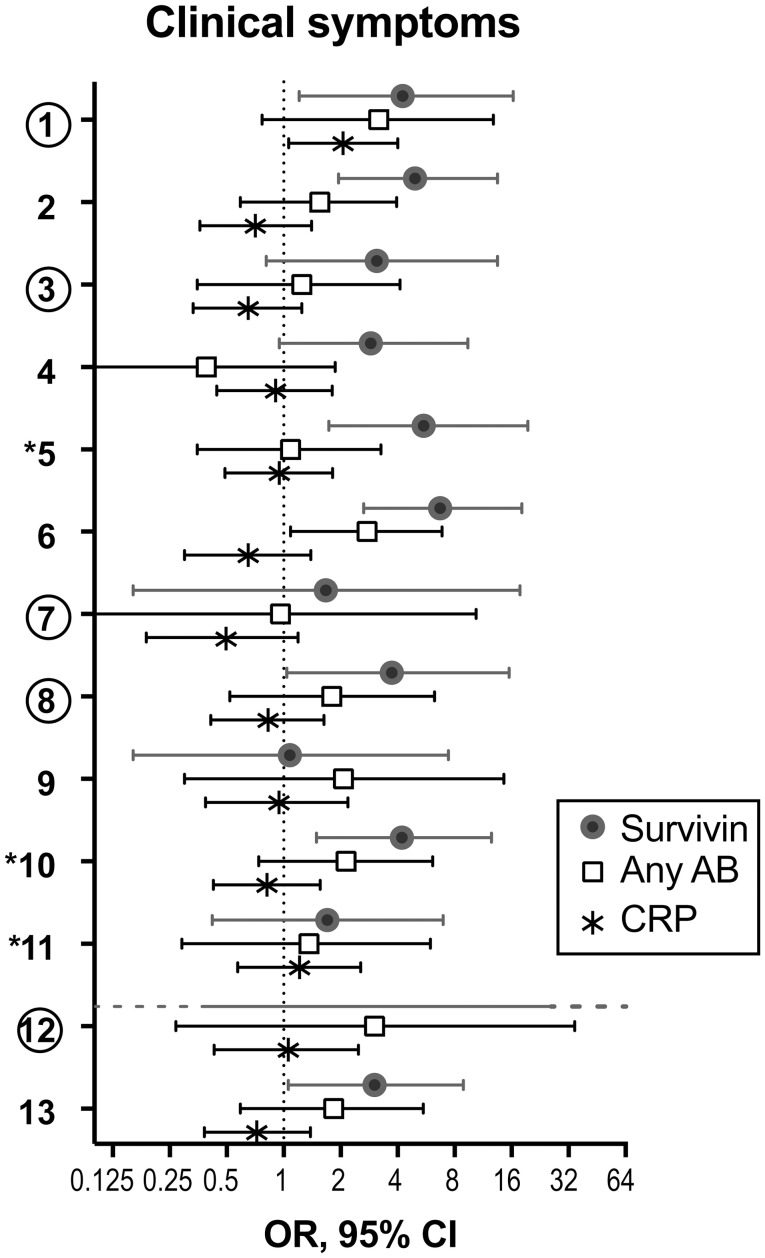
Adherence of serological biomarkers to clinical symptoms of arthralgia. To study if serological biomarkers associate with clinical symptoms of arthralgia, the prevalence of each symptom was compared among patients with and without survivin (filled circles, n = 61 vs. 119), any antibody (anyAB, RF and/or ACPA) (open squares, n = 53 vs. 127) or CRP (asterisk, n = 54 vs. 126). Odds ratio (OR) with 95% confidence interval (CI) is presented for each clinical symptom. The 3 symptoms marked with asterisk distinguish pre-RA cases. The 5 symptoms marked with circles comprise by consensus the positive definition of arthralgia in progression to RA. (1) Joint symptoms onset <1 year, (2) 4–10 joints with symptoms, (3) Symptoms in MCP joints, (4) Symptoms in MTP joints, (5) Symptoms in several small joint regions, (6) Symmetric symptoms and signs, (7) Duration of morning stiffness >60 min, (8) Most severe symptoms in the early morning, (9) Improvement of symptoms during the day, (10) Increasing number of joints with symptoms over time, (11) Patient experience of swelling of small hand joints, (12) Presence of a first-degree relative with RA, (13) Local tenderness involved joints at physical examination.